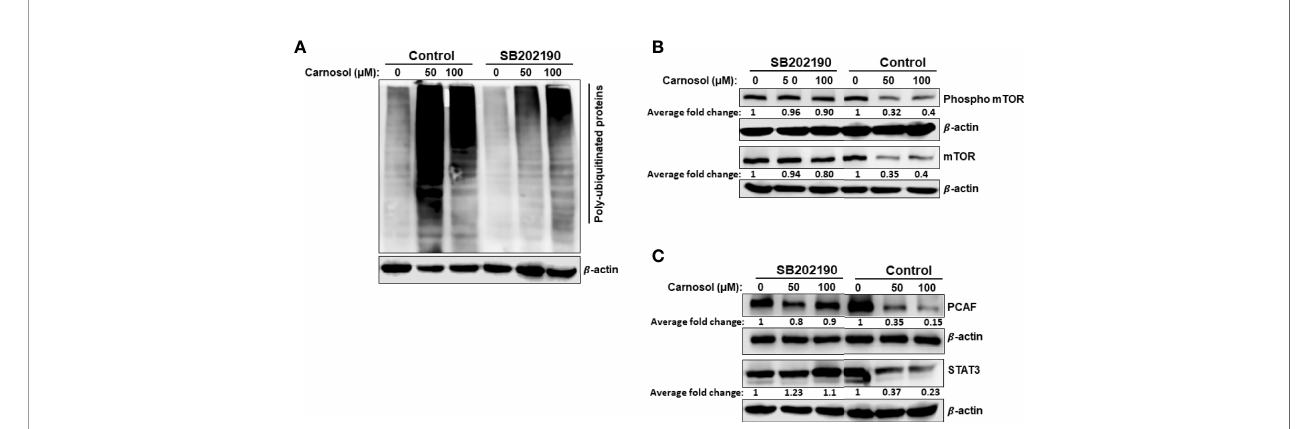
FIGURE 8 | Inhibition of p38MAPK reduces carnosol-mediated protein polyubiquitination and proteasome degradation of mTOR, STAT3, and PCAF. (A) Inhibition of p38 reduces the level of polyubiquitinated proteins in MDA-MB-231 cells. Cells were pre-treated for 1h with or without SB202190 (50 m M) before treatment with carnosol (50µM). Whole cell lysates were subjected to Western blotting analysis for ubiquitinated proteins. (B, C) SB202190 restored mTOR PCAF and STAT3 proteins to a level comparable to control cells. Cells were treated as described in (A) and whole protein lysates were subjected to Western blotting analysis for mTOR and phospho-mTOR (B) and PCAF and STAT3 (C)